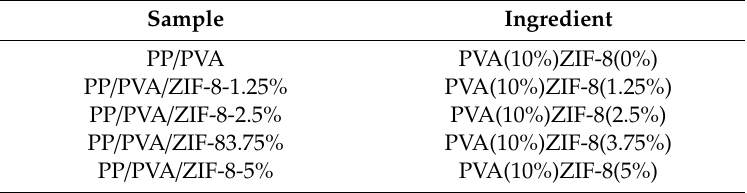
Table 4. Denotations and compositions of PP/PVA/ZIF-8 melt-blown electrospun composite membranes.